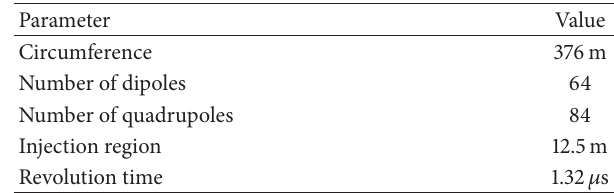
Table 4: Summary of lattice parameters for the